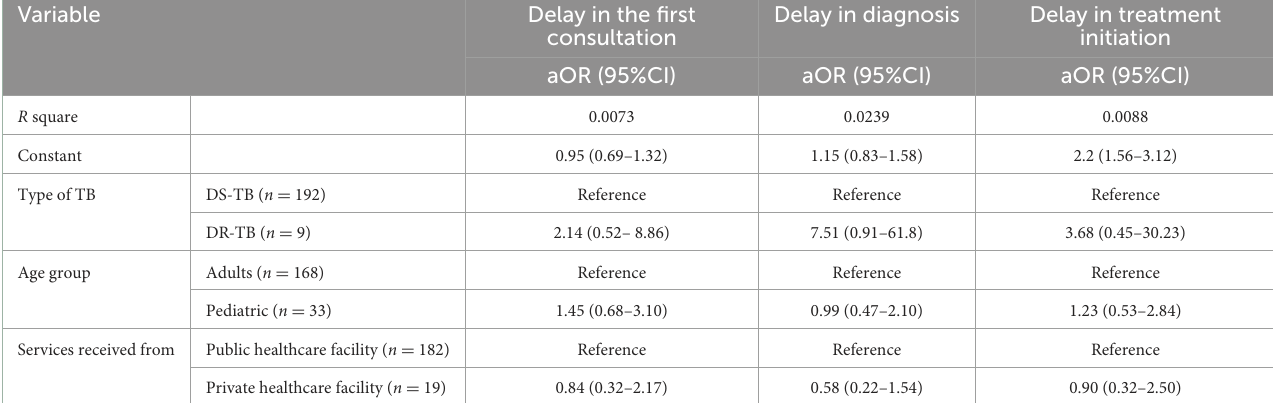
TABLE 5 Analysis of the delay in the various care cascade phases amongst the various extra-pulmonary TB patients ( N = 201).